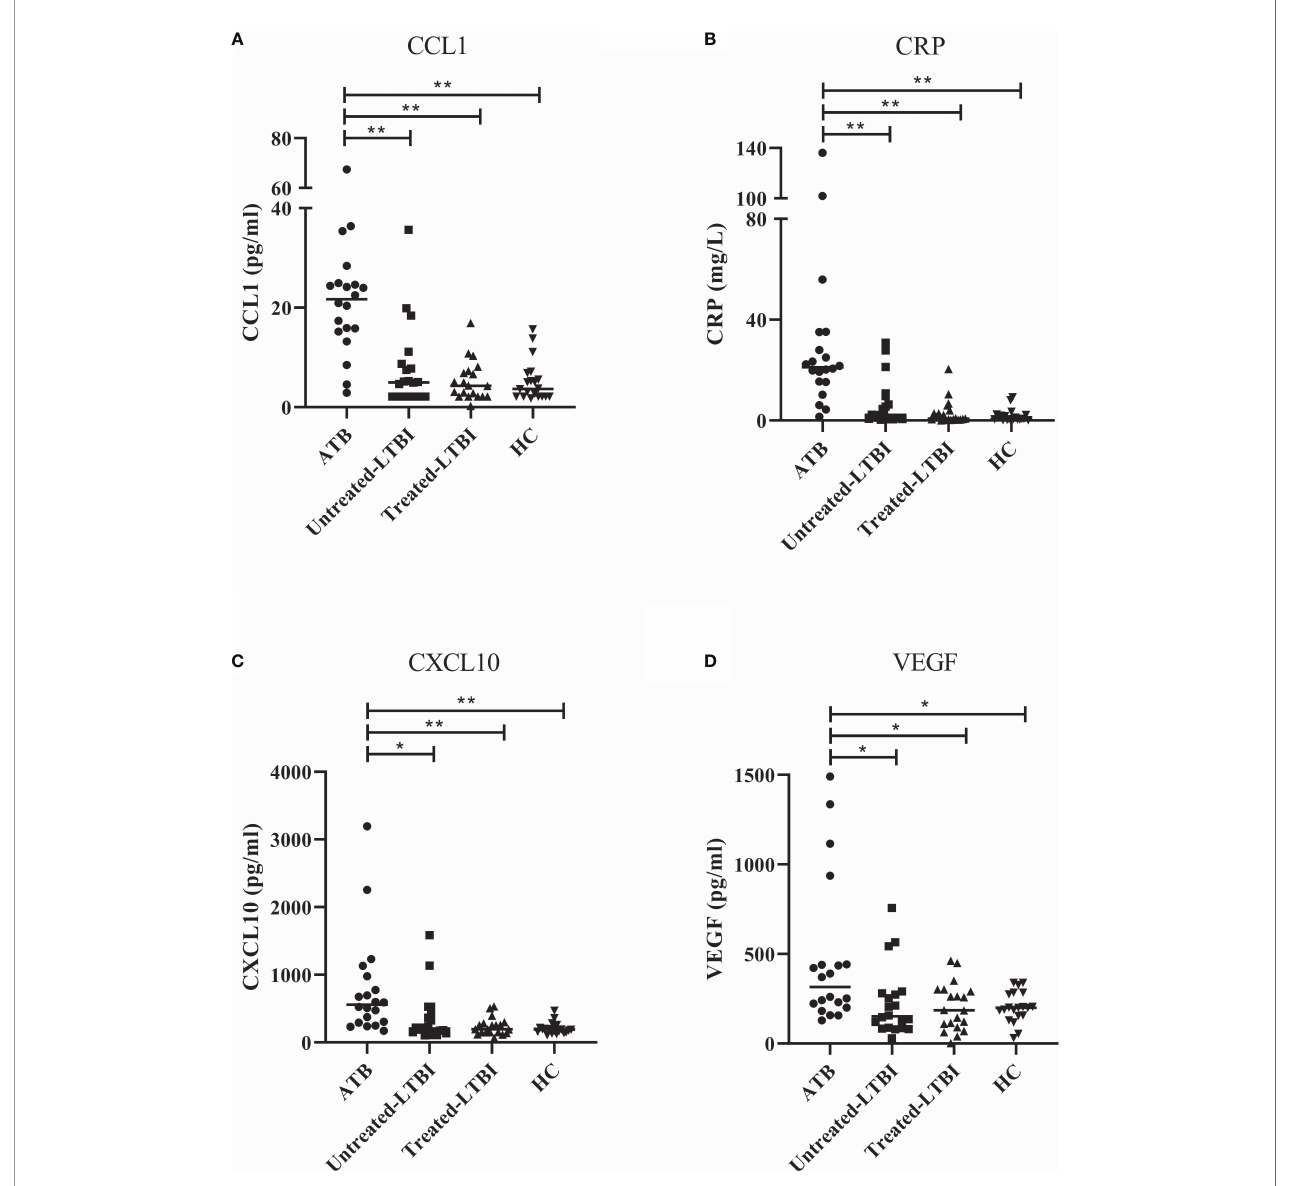
FIGURE 2 | Serum levels of CCL1 (A) , CRP (B) , CXCL10 (C) , and VEGF (D) in individuals with ATB, untreated LTBI, and treated LTBI and HCs. All groups were compared for each marker using Mann – Whitney U tests. In panels (A – D) , the fi lled dots represent participants with ATB, the fi lled squares represent the participants with untreated LTBI, the fi lled triangles represent the participants with treated LTBI, and the fi lled inversed triangles represent the HCs. The horizontal line in each study group represents the median concentration. ATB, active tuberculosis; CCL1, C-C motif chemokine ligand 1; CRP, C-reactive protein; CXCL10, C-X-C motif chemokine ligand 10; HC, healthy controls; untreated LTBI, latent tuberculosis infection without prophylaxis; treated LTBI, latent tuberculosis infection after completion of prophylaxis; VEGF, vascular endothelial growth factor. * 0.001 < p < 0.05, ** p <